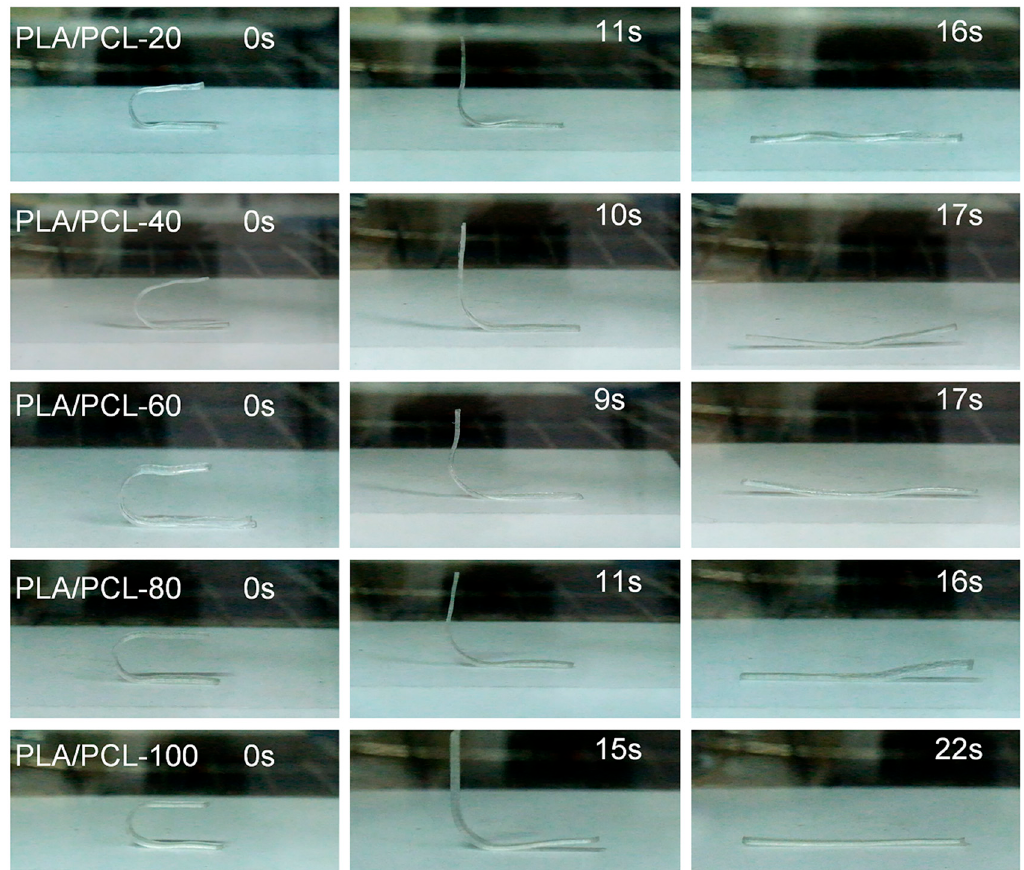
Figure 7. Visualization of shape recovery processes for printed 4D samples.